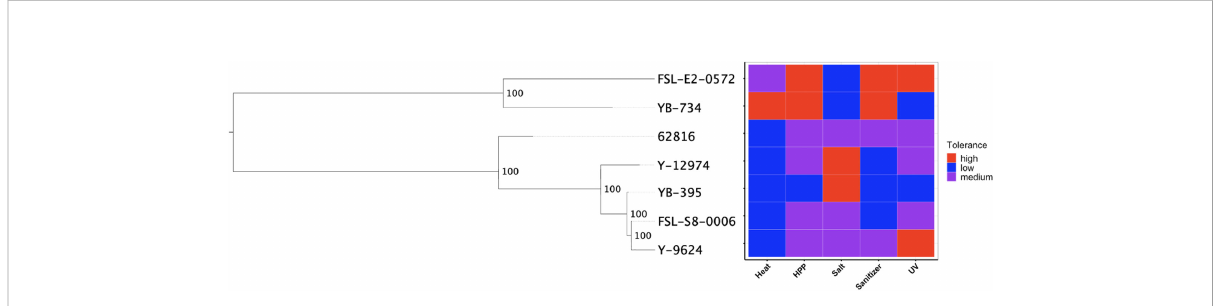
FIGURE 4 SNP-based phylogeny of black yeast isolated from food or food production environments (left) and their relative stress tolerance to diverse food processing conditions